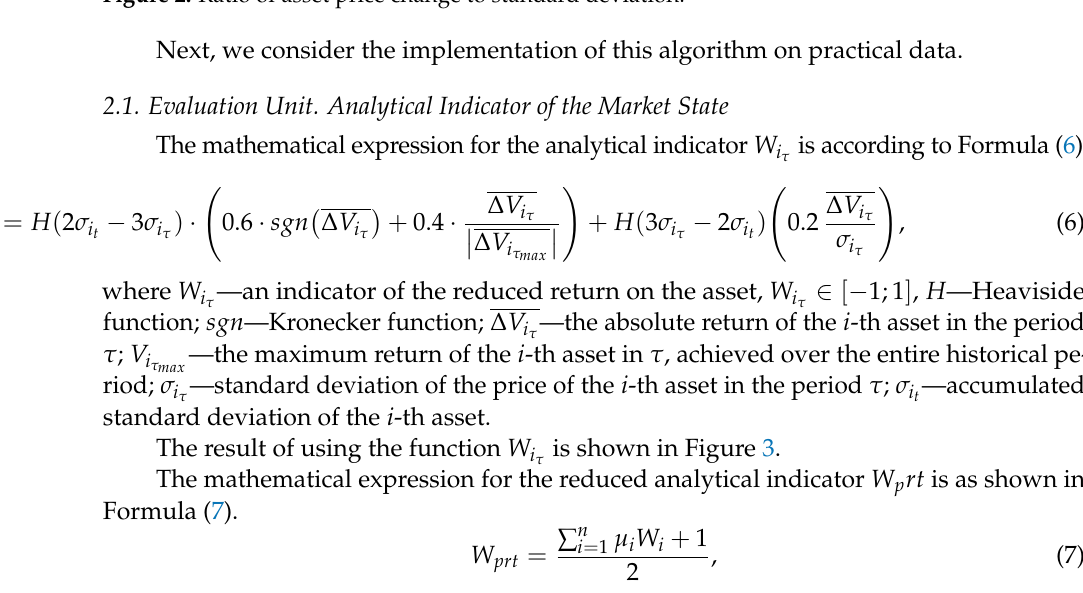
Figure 2. Ratio of asset price change to standard